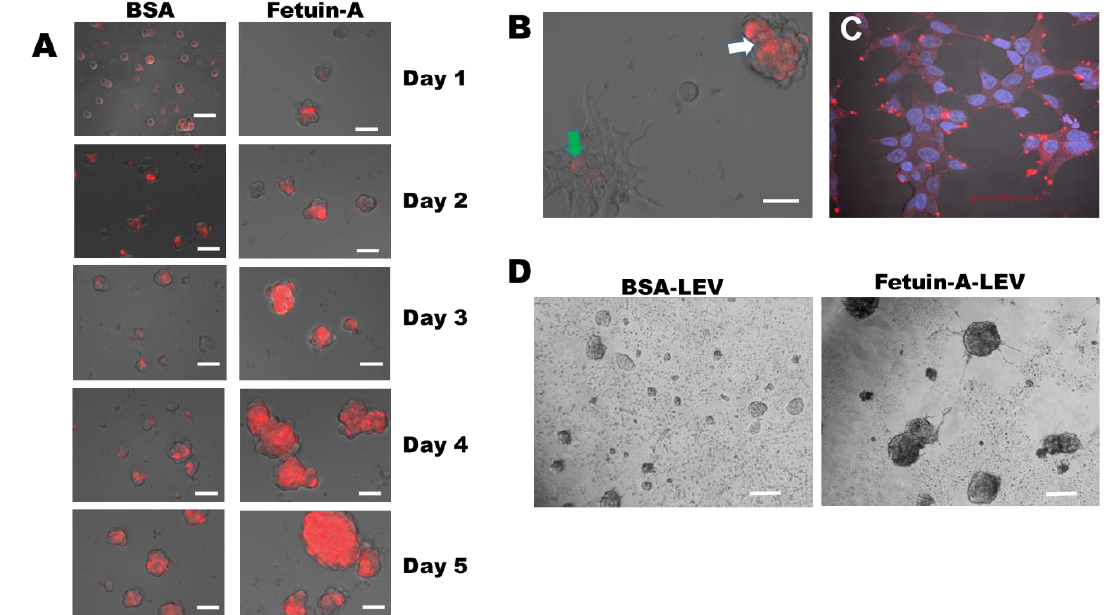
Figure 3. Fetuin-A drives the internalization of labeled LEV in adhered cells but sequesters them on the surfaces of spheroid cells or non-adhered cells. Large extracellular vesicles (LEV) were isolated from LNCaP cells in SFM containing BSA, as described in Materials and Methods. The vesicles were labeled with rhodamine isothiocyanate, purified by passing twice through the desalting column, and again by centrifugation twice (3000× g ) for 15 min each. The pellet was resuspended in SFM to a concentration of 1 mg/mL. In panel ( A ), LNCaP cells were plated in 96-well low attachment plates (5000 cells/well) in SFM containing BSA or fetuin-A (2 mg/mL). To each well, 15 µg of labeled LEV was added, and the cells were incubated for 5 days. The cells with labeled LEV were photographed every day for 5 days under a Keyence epifluorescence microscope adjusted to acquire fluorescence images of cells growing on plastic plates. In ( B ), the same number of cells was plated on cell culture-treated high attachment 96-well plates. Each well contained 15 µg of labeled LEV. The wells were photographed after 4 days, by which time most of the label in the spread cells had dissipated. In ( C ), the cells were plated on glass coverslips in complete medium. After 24 h, labeled LEV (10 µg) was added to the adhered cells in complete medium and incubated for 2 h, fixed in 3.5% paraformaldehyde in PBS, washed, and then the coverslip was placed upside down on a drop of anti-fade with DAPI on a slide and images acquired by confocal microscopy (Nikon A1R). In ( D ), the cells growing in low attachment 96-well plates containing 15 µg/well of unlabeled LEV in SFM containing either BSA or fetuin-A (scale bars in panels ( A , B , C , D ) = 50 µm). The experiment was repeated 3 times.